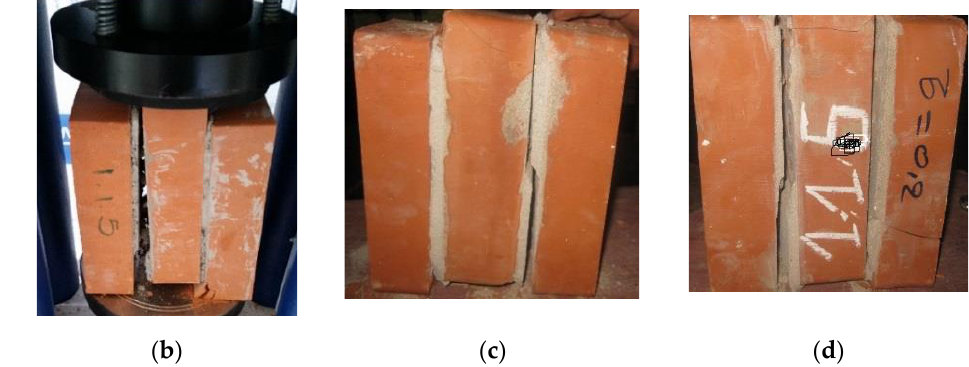
Figure 4. Typical failure modes observed during the shear triplet tests: ( a ) sliding a long bed joint, ( b ) diagonal shear cracking at mortar and crashing at the bottom of right, ( c ) diagonal shear crack at mortar on the right side, ( d ) diagonal shear cracking at mortar and sliding at the brick–mortar interfaces; cracking appears at the bottom of right